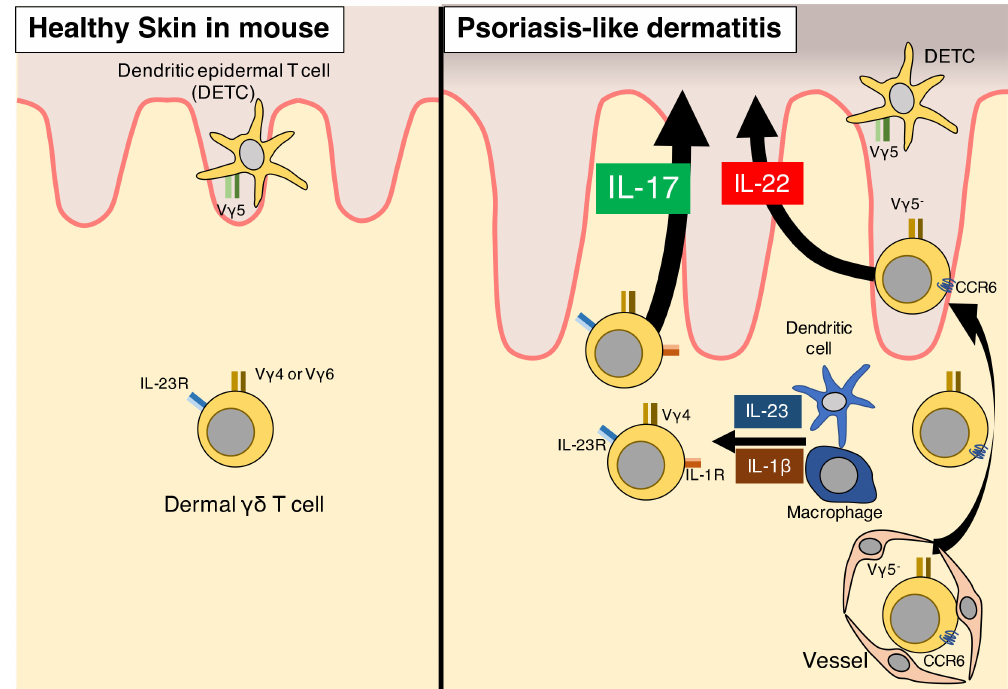
Figure 2. Role of γδ T cells in mouse models of psoriasis. V γ 4 and V γ 6 γδ T cells are present in normal mouse skin. Dermal V γ 4 γδ T cells increase in psoriasis-like dermatitis lesions generated by imiquimod application. V γ 4 and V γ 6 γδ T cells, rather than αβ T cells, produce IL-17. C-C motif chemokine receptor 6-positive (CCR6 + ) γδ T cells lacking V γ 5 are recruited from the peripheral blood into